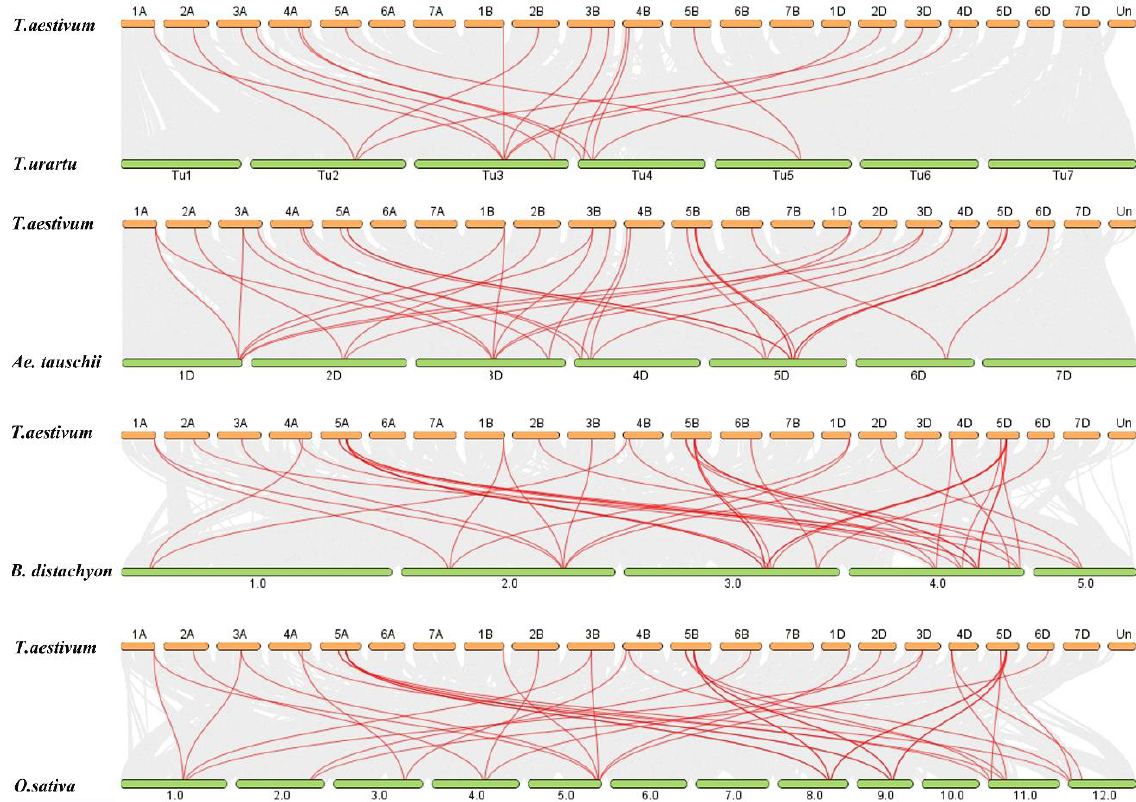
Figure 5. Syntenic relationships between TaZF-HD genes in T. aestivum with other ZF-HD genes in four representative plant species. Gray lines in the background indicate the collinear blocks within T. aestivum and other plant genomes and red lines highlight the syntenic ZF-HD gene pairs.